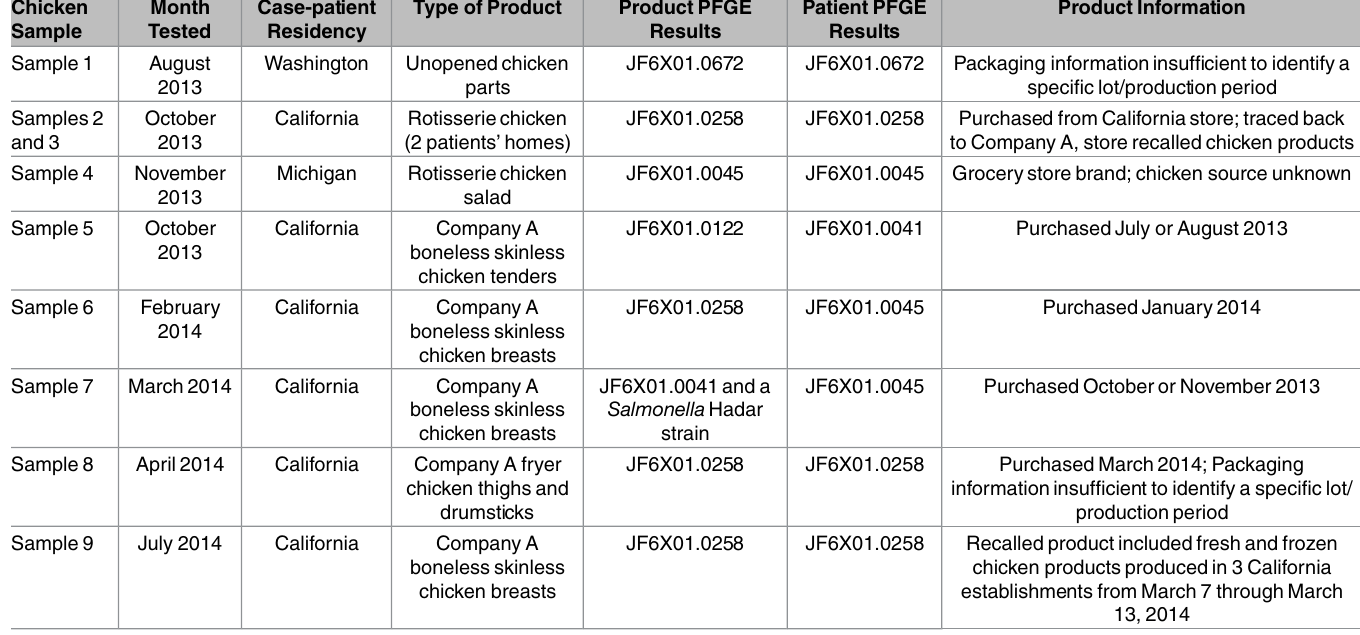
Table 2. LeftoverChicken Products Collectedfrom Case-Patient Homes,Multistate Outbreak of Multidrug-Resistant Salmonella Heidelberg Infec- tionsLinkedto a SinglePoultry Company, 2013–2014. Chicken